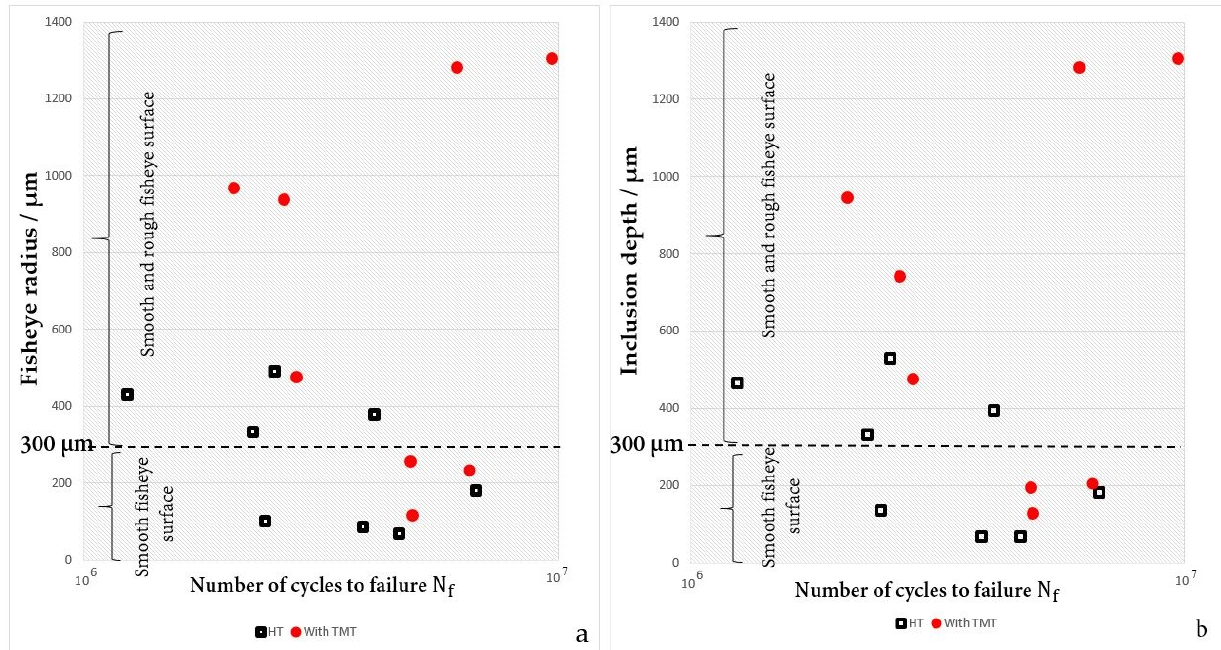
rough fisheye around the smooth one (fisheye formation in two stages, (cid:1840) (cid:3033) = 9,706,545 cycles, inclu- sion depth = 1.3 mm).